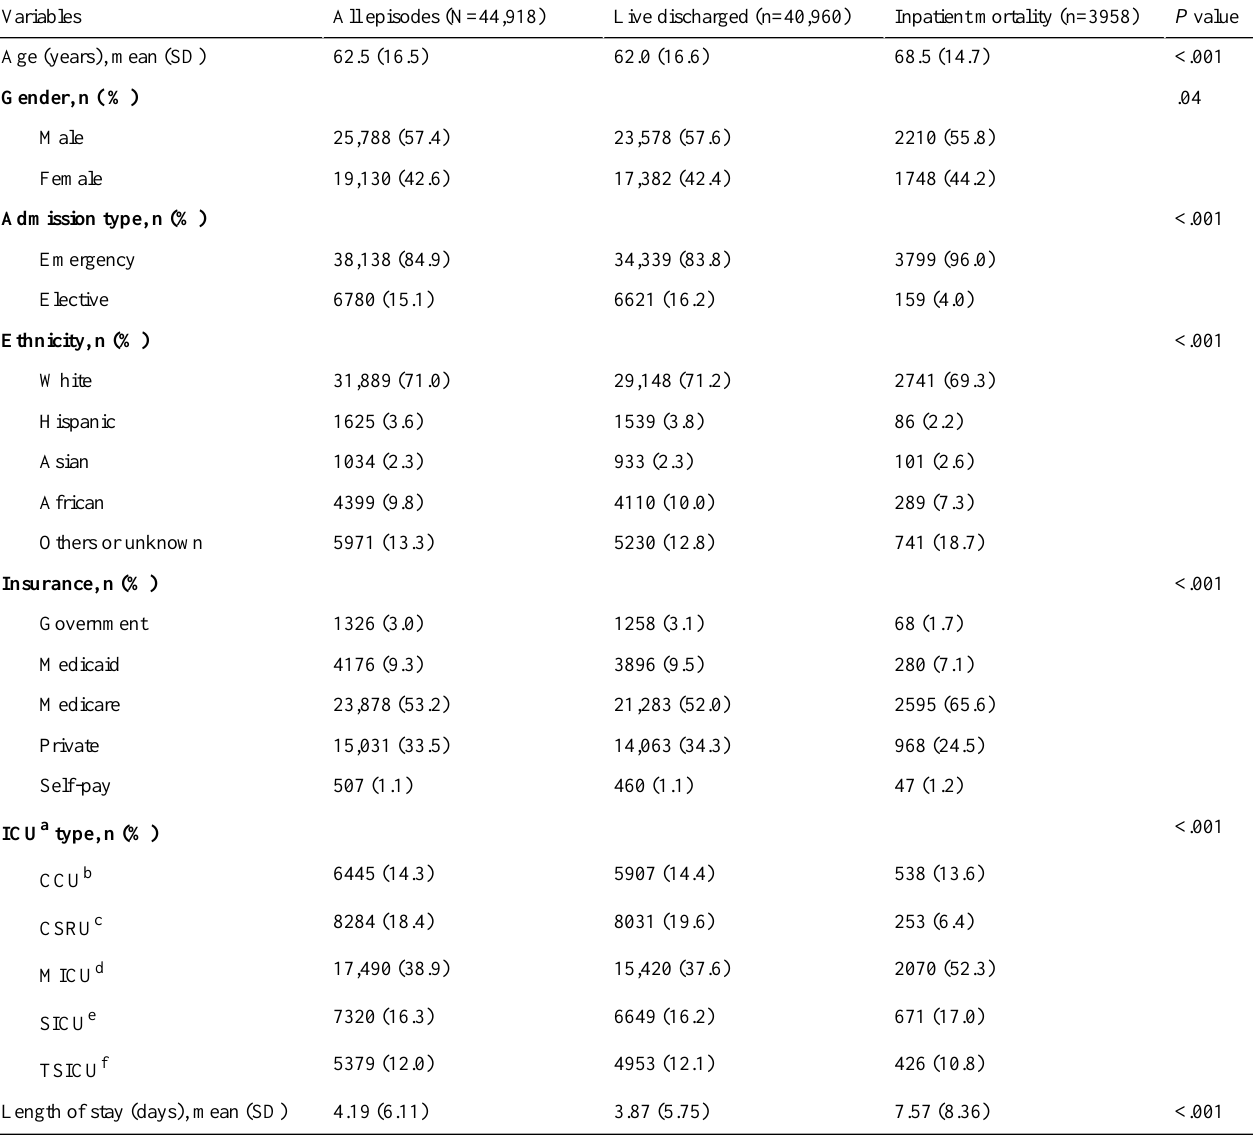
Table 1. Description of the study cohort